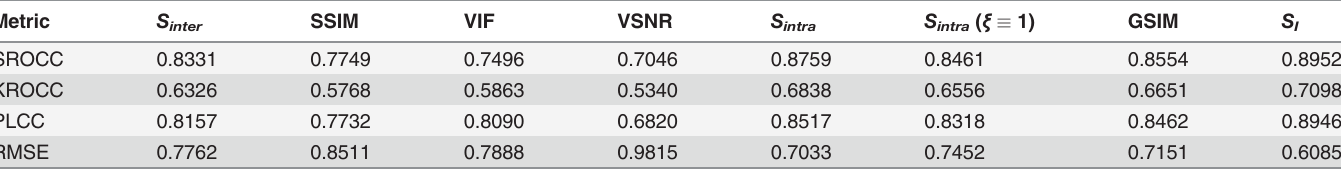
Table 7. Performance of each component on TID 2008.